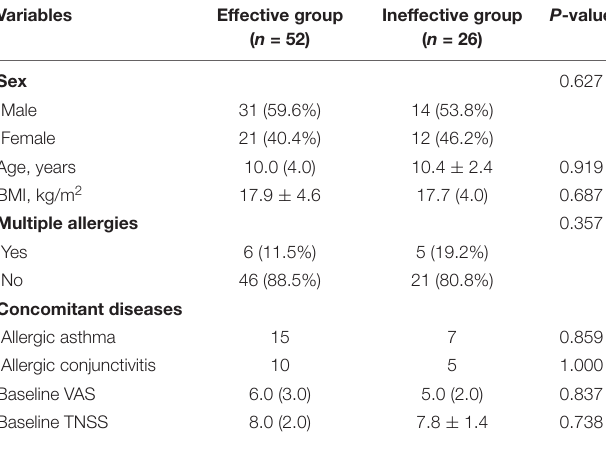
TABLE 2 | Demographics and clinical characteristics of patients in validation